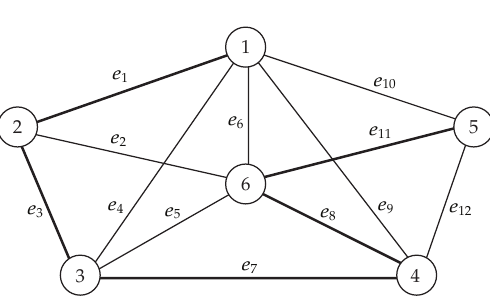
Figure 3: Optimal spanning tree of probability maximization-based BST problem.